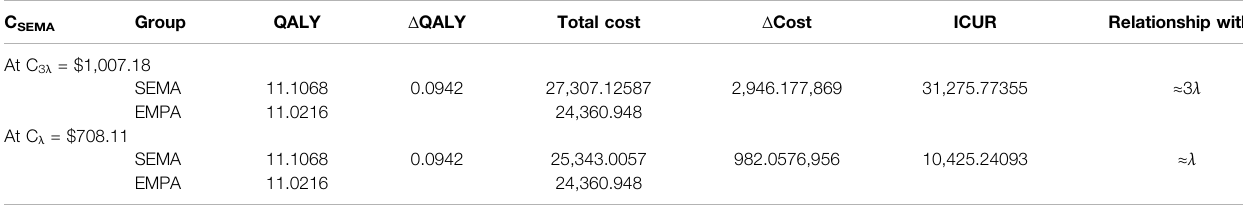
TABLE 6 | Results for searching C λ and C 3 λ .